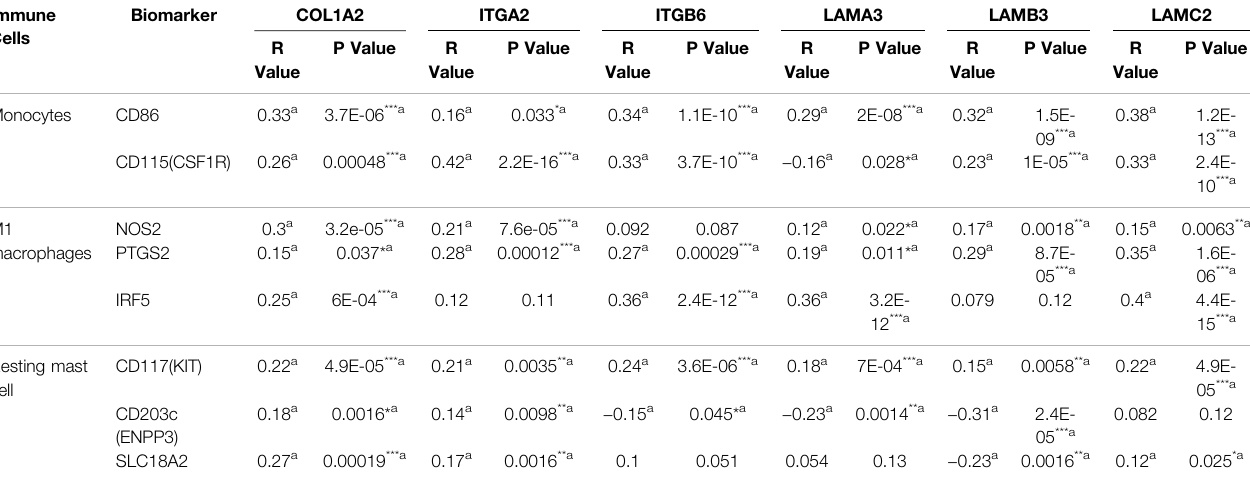
TABLE 2 | Relationship between hub genes and biomarkers of immune cells in PAAD detected by GEPIA. Immune Cells